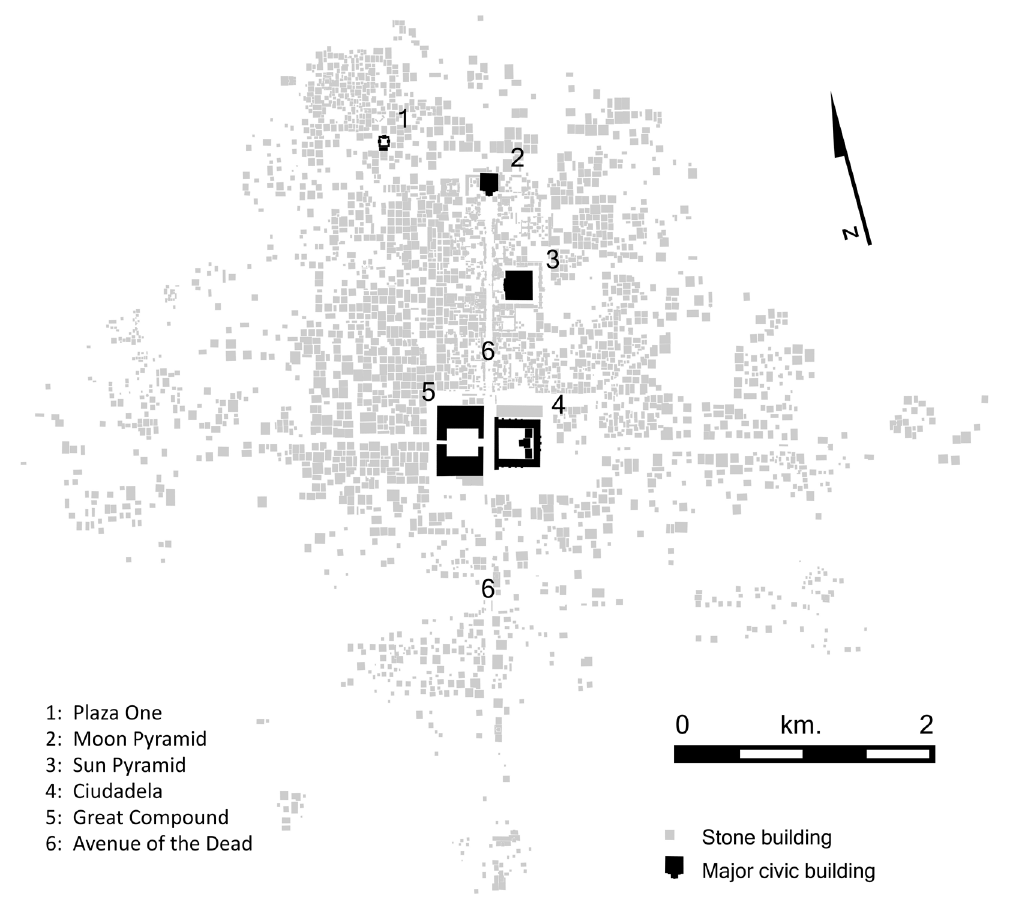
Figure 4. Plan of Teotihuacan. Numbers indicate important civic buildings discussed in the text. This plan was generated from the GIS model of Teotihuacan developed by the project “Service Access in Premodern Cities” (Stanley et al., 2016). The GIS model is based on a digitized version of the Teotihuacan Mapping Project map of the city (Millon, Drewitt, & Cowgill, 1973). Alexandra Norwood created the output for this